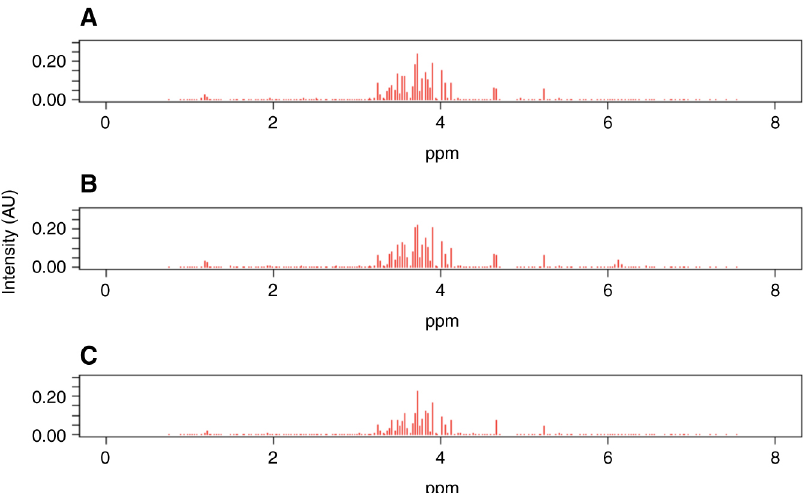
Figure 1: 1 H-NMR mean spectra plots for each season. Each plot was obtained from the ppm mean of the different sam- ples for each season. (A) Spring season. (B) Summer/Autumn season. (C) Winter season.